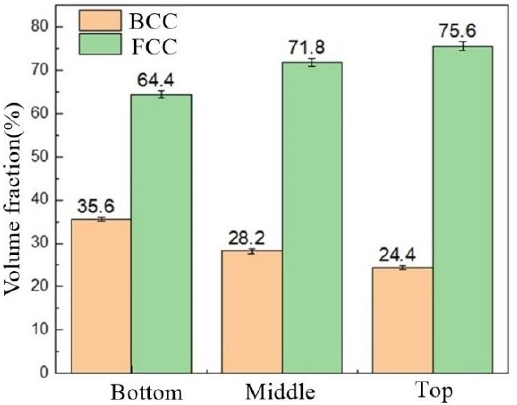
Figure 7. Phase volume ratios at different positions of the additive part.